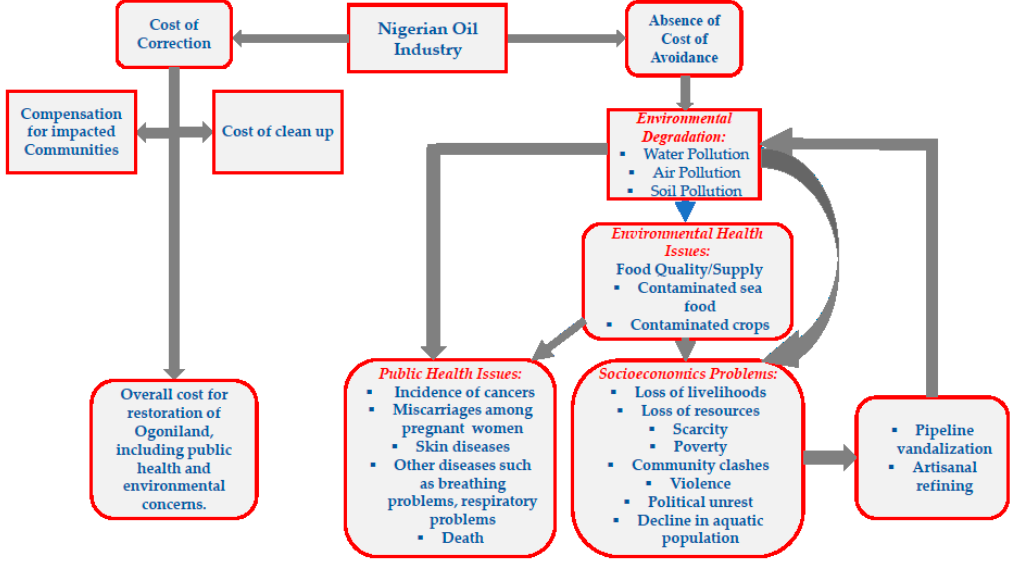
Figure 1. “Cost of Quality” conceptual framework showing the convoluted environmental, public health, and socioeconomic issues in Ogoniland.